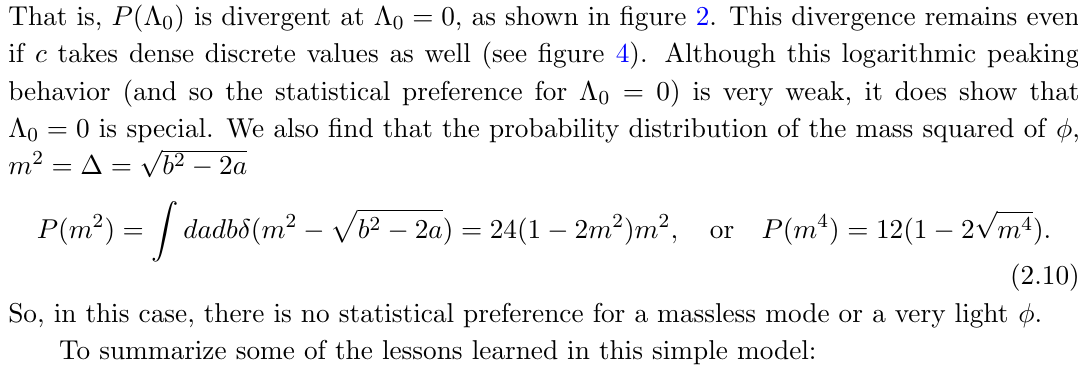
2 ) (right) for the tree-level (cid:30) 3 model with Figure 2 . Probability distribution P ((cid:3) 0 ) (left) and P ( m coe(cid:14)cient c = 1. Histograms under the (approximate) analytic curves are numerical data. Here P ((cid:3) 0 ) diverges logarithmically at (cid:3) 0 = 0, while P ( m 2 ) peaks at m 2 (cid:24) 0 : 26. That is, P ((cid:3) 0 ) is divergent at (cid:3) 0 = 0, as shown in (cid:12)gure 2. This divergence remains